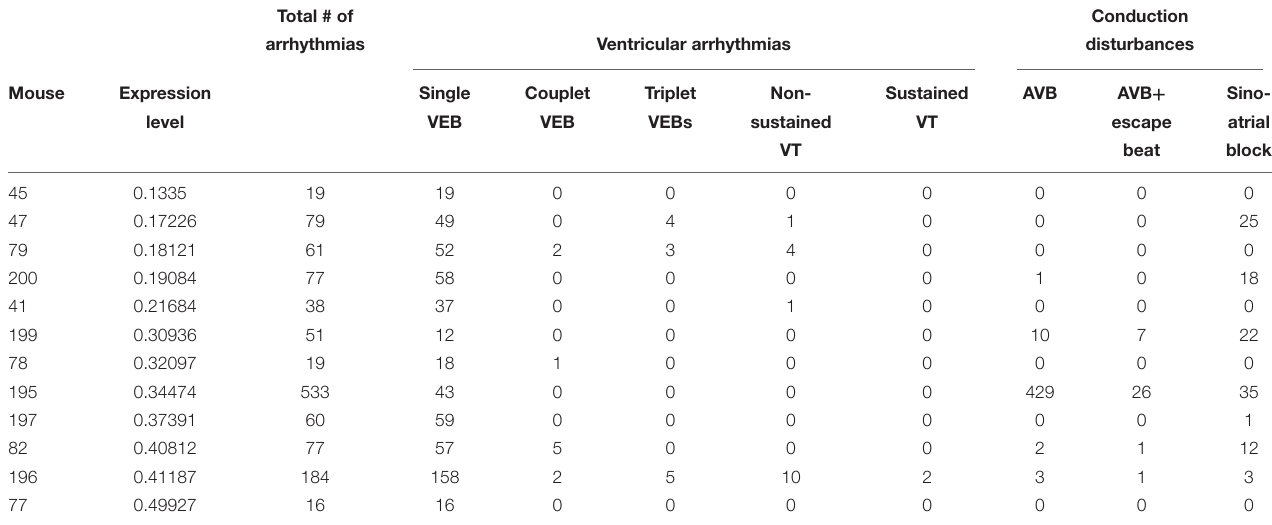
TABLE 2 | Protein expression level and all arrhythmic events displayed by WT-mice subjected to TRPM4 expression during exercise-induced stress conditions. Total # of Conduction arrhythmias Ventricular